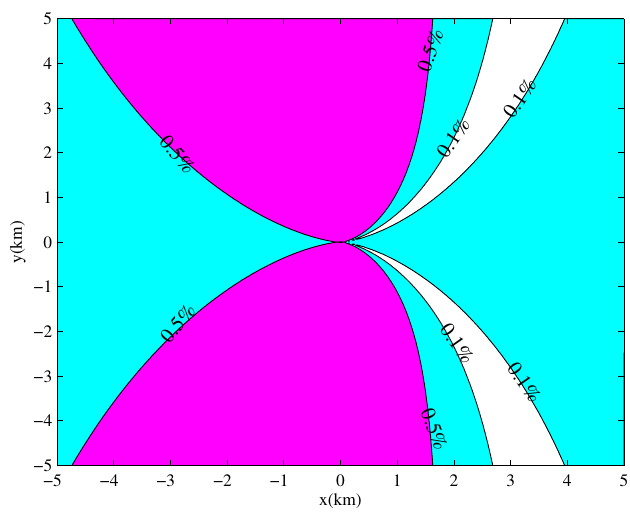
Figure 5. The filled contour plot of the Doppler frequency shift variance with motion type 3.